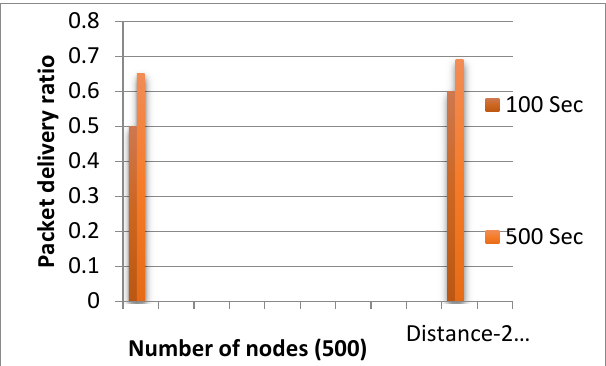
Figure. 7 Comparison of packet delivery ratio for 500 nodes.